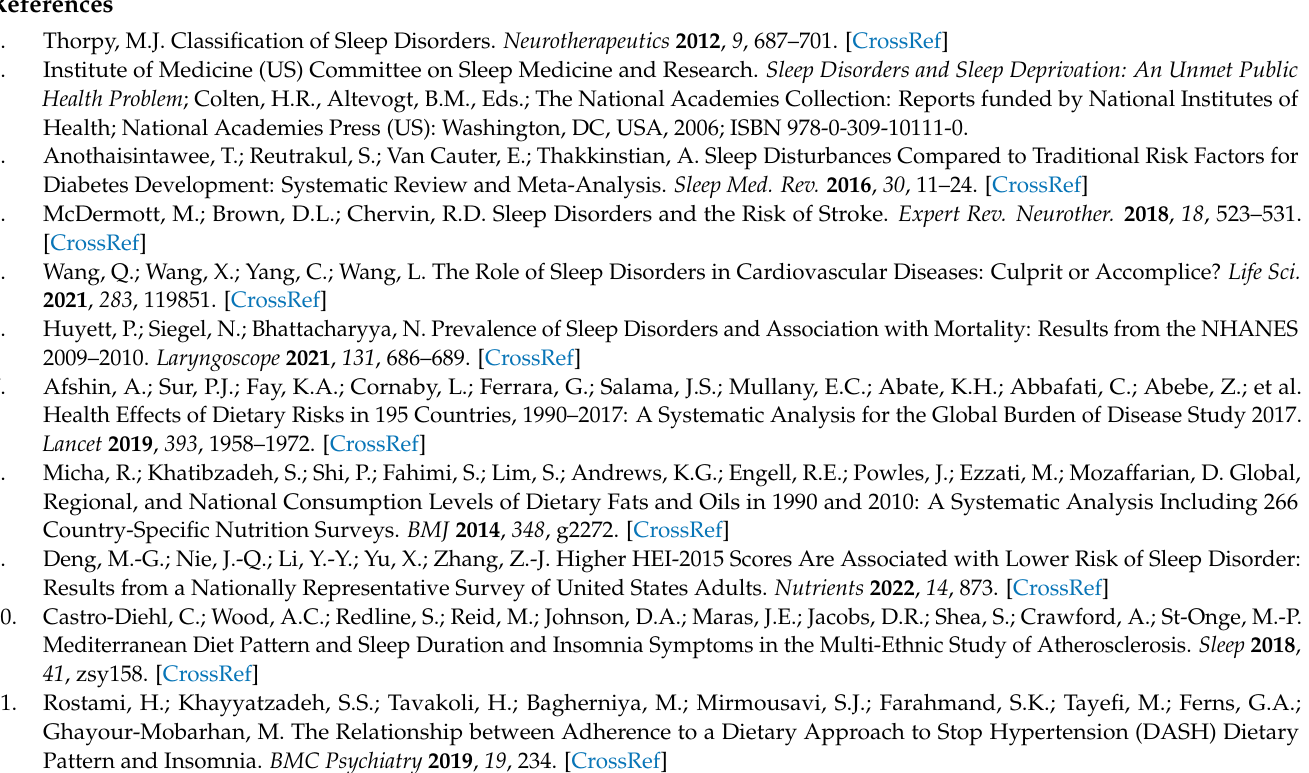
Table S3: Characteristics of study participants by quartiles of dietary pattern scores in “low whole grains, vegetables, and fruits” pattern; Table S4: Factors related to anthropometric characteristics of study participants by quartiles of dietary factor scores in two dietary patterns; Table S5: Odds ratios of sleep disorders and corresponding 95% Cis according to quartiles of dietary pattern scores from partial least squares adjusted for the reporting groups; Table S6: Coefficients of sleep duration and corresponding 95% Cis according to quartiles of dietary pattern scores from partial least square adjusted for the reporting